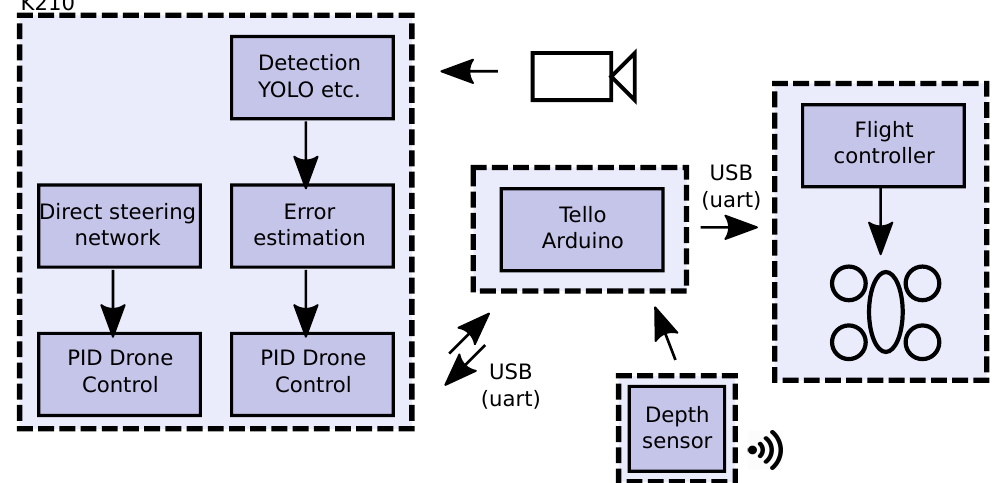
Figure 8. Overview of our hardware